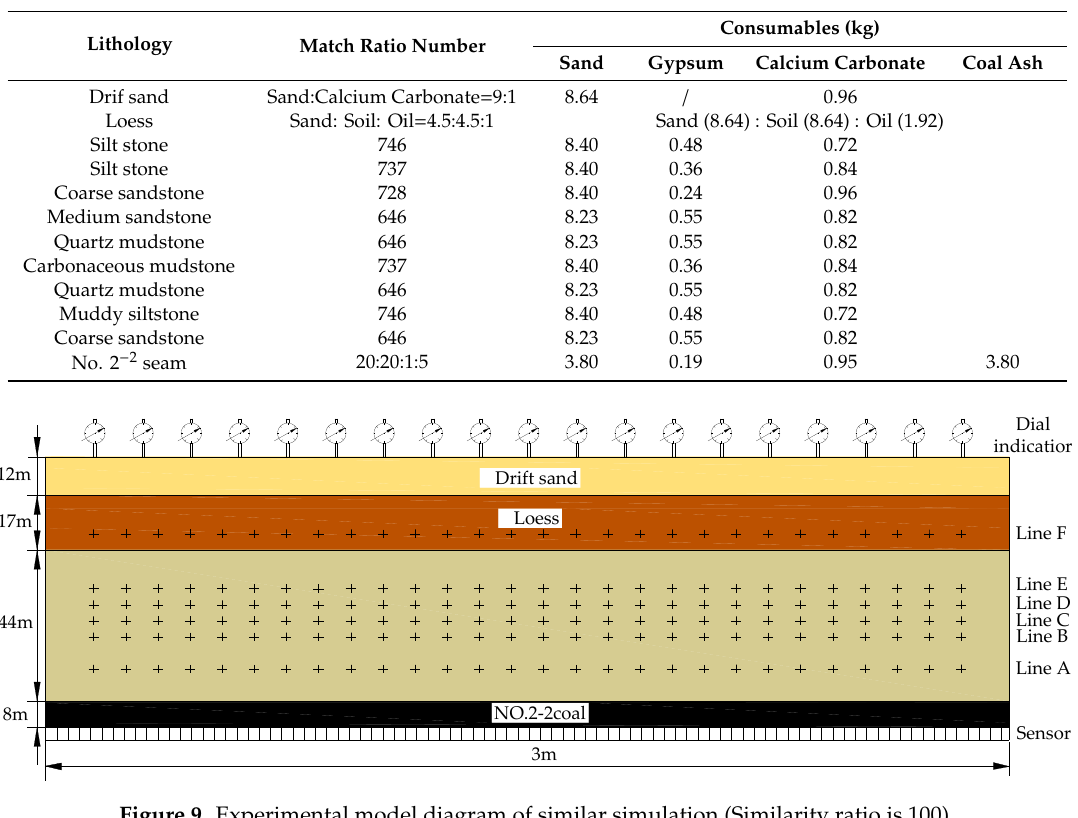
Table 2. Physical simulation experimental material ratio of No. 22201 working face.